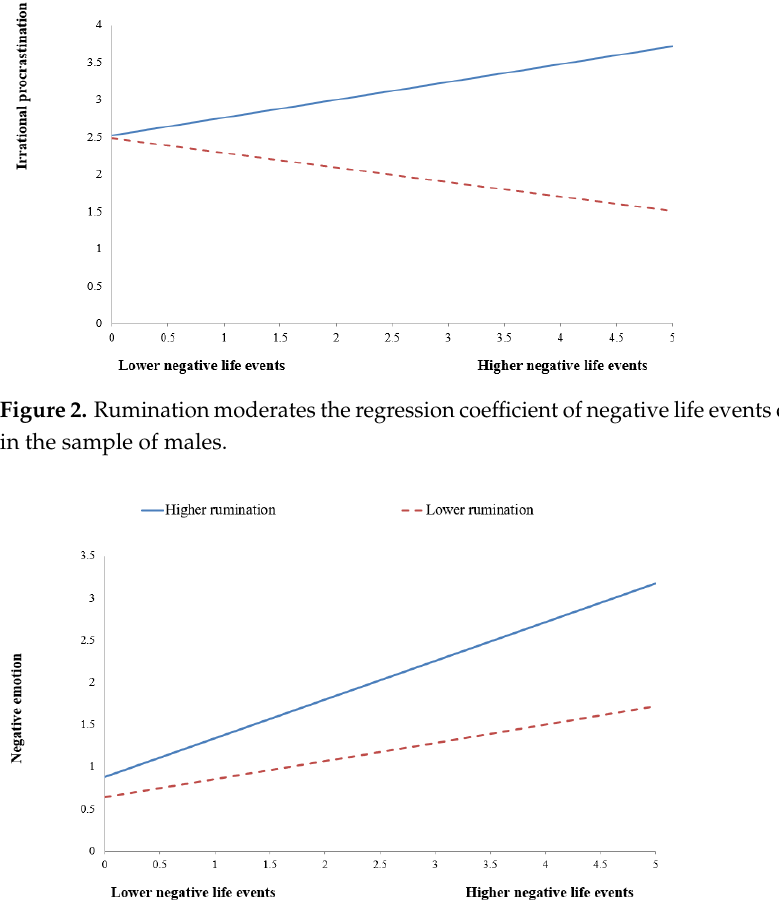
Figure 3. Rumination moderates the regression coefficient of negative life events on procrastination in the sample of males.